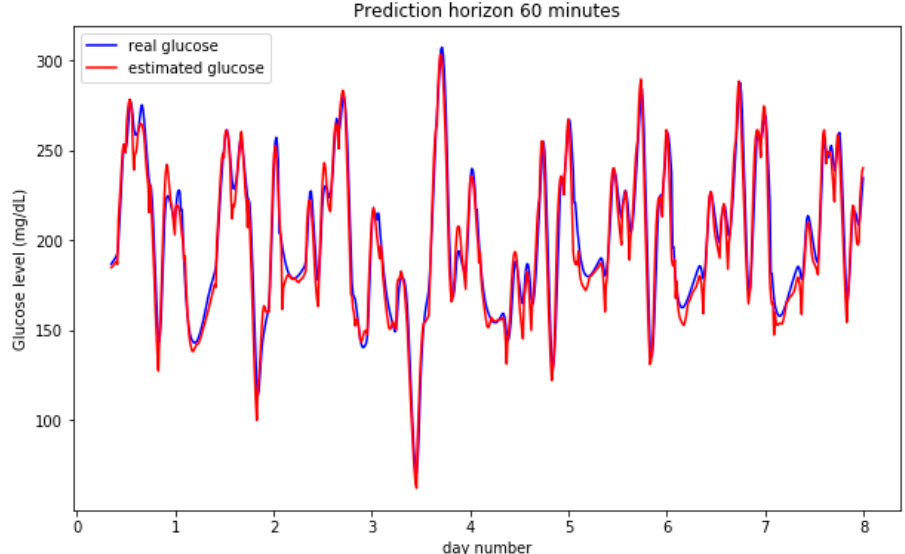
Figure 3. Predictions on a 60 min horizon for 8 days for a simulated participant.